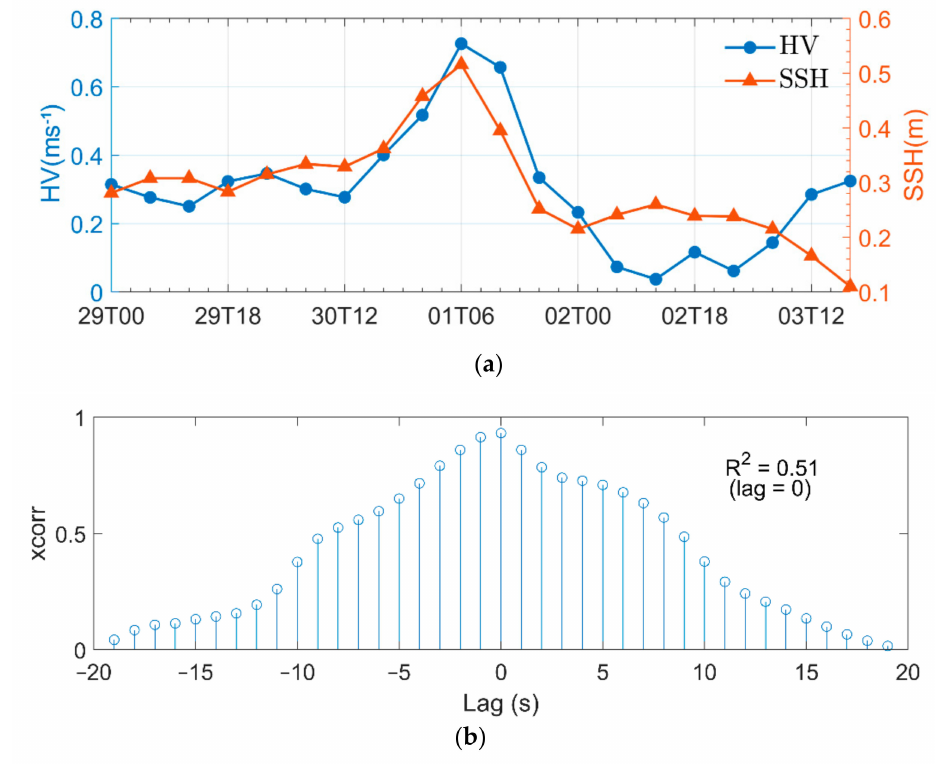
Figure 11. ( a ) The variation of sea surface current horizontal velocity (HV) and sea surface height (SSH) at Zhoushan sea area. ( b ) The cross-correlation analysis diagram of SSH and